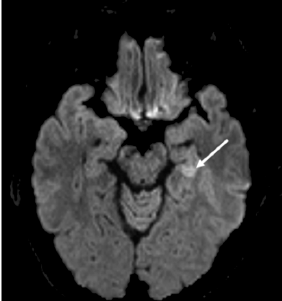
Figure 1. Fluid-attenuated inversion recovery (FLAIR), magnetic resonance imaging (MRI)